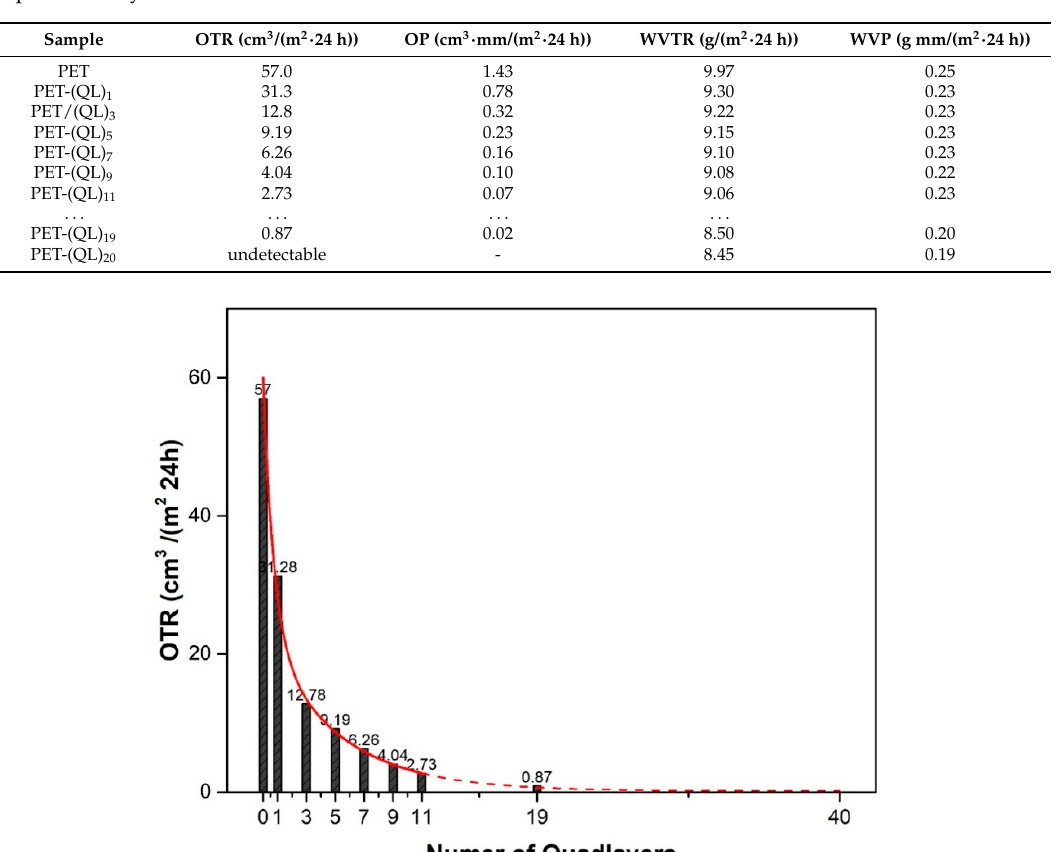
Figure 13. OTR values as a function of the number of QLs deposited on PET film.